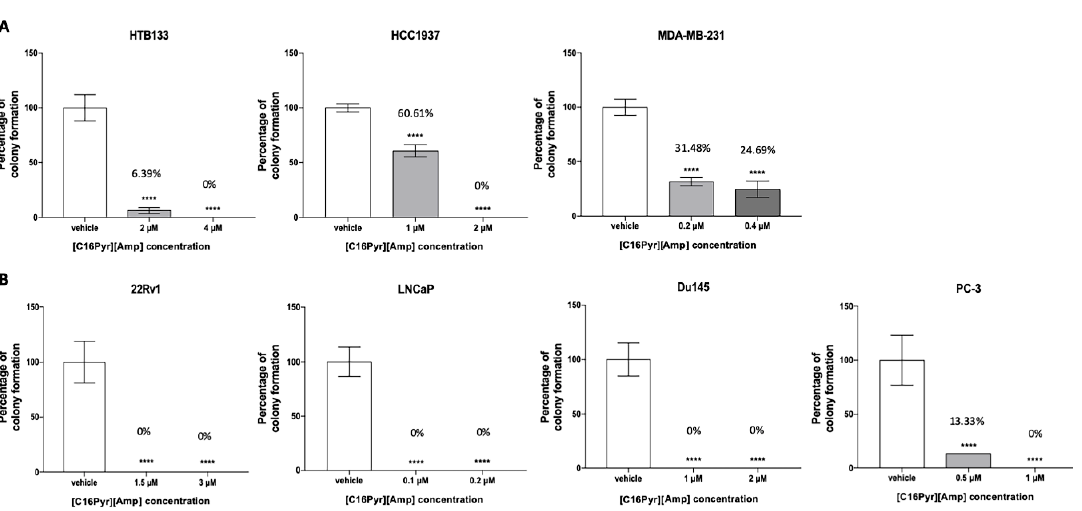
Figure 3. Effect of [C16Pyr][Amp] on the colony formation ability of the ( A ) BrCa and ( B ) PCa cell lines after treatment compared to the vehicle. All data are presented as mean of three independent experiments ± SD (**** p < 0.0001).